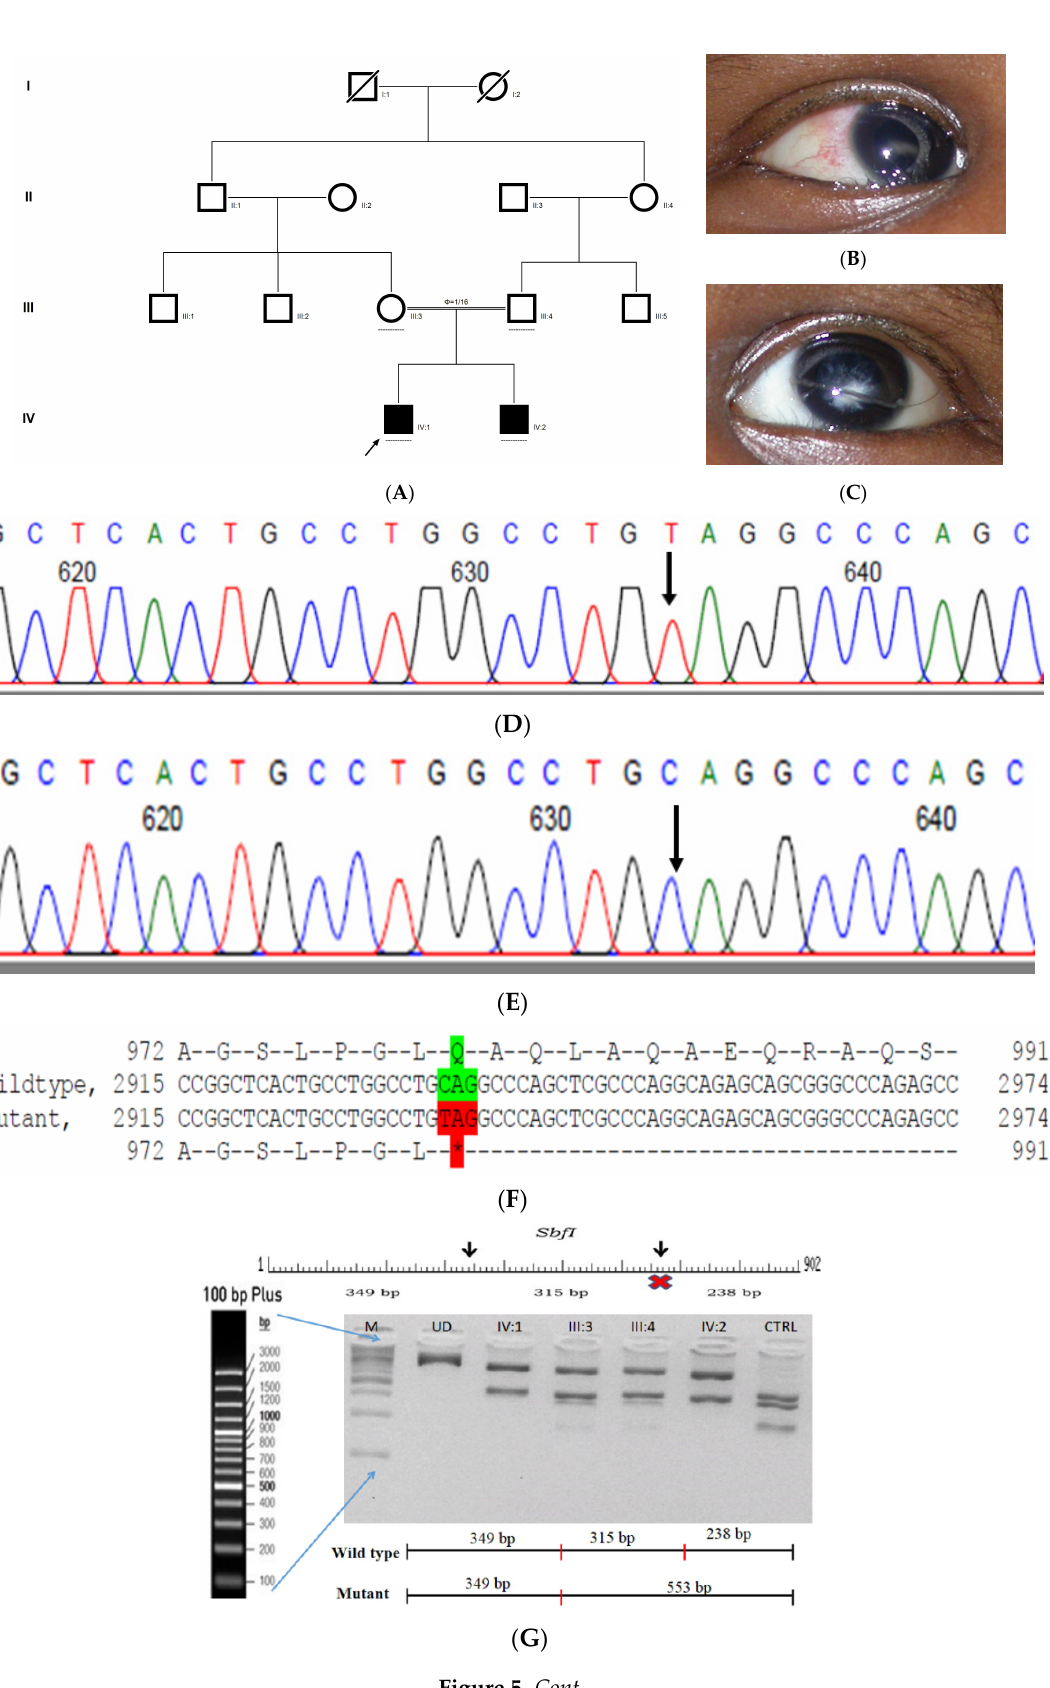
( H ) Figure 5. Pedigree of ACR12 ( A ). Eye picture of the proband (IV:1)—right eye ( B ) depicting posterior cortical cataracts and left eye ( C ) depicting Lamellar cataracts. Partial sequence chromatograms of the proband (( D) , IV:1) and control subject ( E ), FYCO1 exon 8, depicting a homozygous mutation (c.2935C > T; p.Gln979*). Mutant and wildtype nucleotide peaks “T” and “C” marked by an arrow. Mutational consequence leading to truncation (in red) compared with the wildtype sequence (in green) ( F ). RFLP analysis of the mutation p.Gln979* in FYCO1 ( G ), which shows co-segregation among the affected family members (IV:1 and IV:2). Unaffected parents are carriers (III:3 and III:4). Control (CTRL- DKC190) shows complete digestion. UD—undigested PCR product of the control sample. Amino acid sequence alignment of human FYCO1 and orthologs from other species ( H ) showing the conservation of p.Q979 (encircled in red). 2.9. Family Code: BCC23 The proband who is deaf and dumb had dense cortical cataracts in his LE and posterior subcapsular cataracts in his RE (Figure 6B). He had two affected siblings, who had posterior subcapsular cataracts, depicting an autosomal-recessive pattern of inheritance (Figure 6A), and both siblings were deaf and dumb. The mother had mild blue dot opacities in both her eyes, while the father was unaffected. Two possible variants were documented in WES to be causative in this family. One of the variants occurred in the gene FYCO1 as an in-frame deletion of three base pairs, leading to a loss of a single amino acid (c.4288_4290del; p.Glu1430del) (Figure 6C–E). This variant was homozygous in the two affected siblings, and the unaffected proband’s father was a heterozygous carrier for this variant (data not shown). The deleted amino acid residue is highly conserved across species (Figure 6F). The deleted three nucleotides were conserved across species (PhyloP (scores 1.5, 4.301 and 5.18 values for individual nucleotides in the order of deletion) and PhastCons (score 1 for all the three nucleotides)). This variant was observed in the Gnom AD exome database (Formerly known as Exome Aggregation Consortium (EXAC) database) in the Southern Indian population at a very low frequency (0.00002) (no homozygotes observed) (Supplementary Table S1). This variant is categorized as variant of uncertain significance based on ACMG criteria considering PM2 (GnomAD exomes homozygous allele count = 0 is less than 3 threshold for recessive gene FYCO1 (good gnomAD exomes coverage = 96.6).Variant not found in gnomAD genomes (good gnomAD genomes coverage